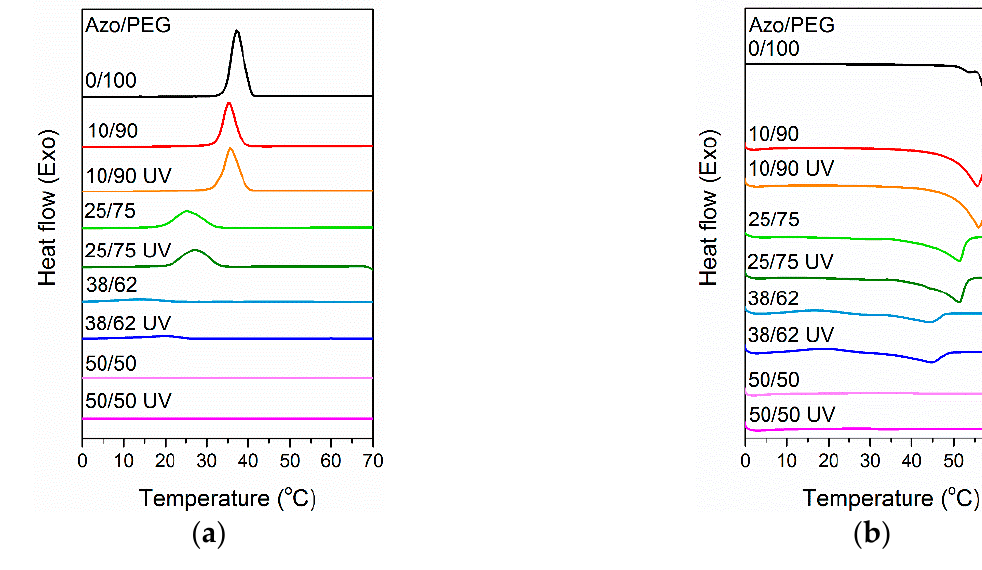
Figure 6. Differential scanning calorimeter (DSC) thermograms of Azo/PEG complexes during ( a ) nonisothermal crystallization and ( b ) reheating. The complex compositions are designated in wt %. Table 2. Thermal and crystallization behaviors of Azo/PEG complexes.